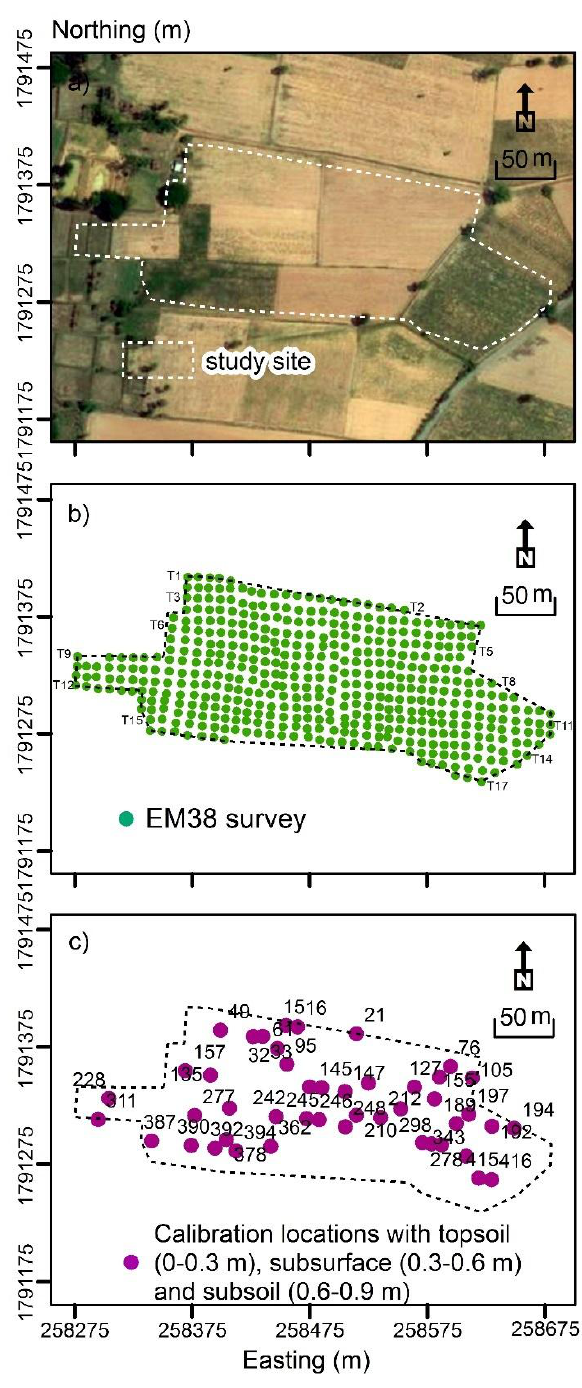
Figure 1. ( a ) Air-photo of study site; ( b ) EM38 survey transects (i.e., 17) and, ( c ) calibration locations (46) where topsoil (0–0.3 m), subsurface (0.3–0.6 m) and subsoil (0.6–0.9 m) samples.